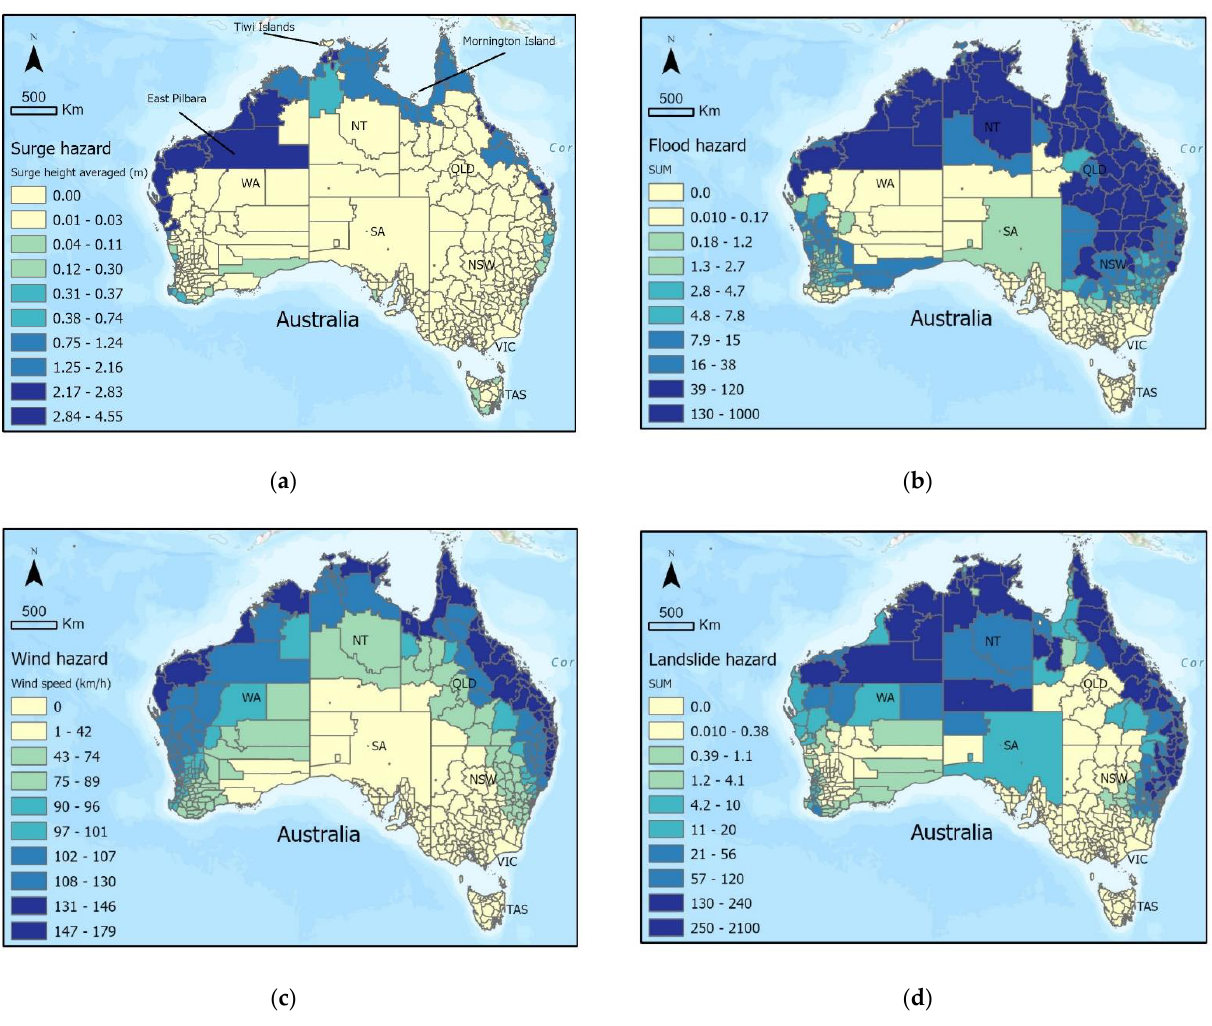
Figure 5. Hazard maps of storm surges ( a ), floods ( b ), wind ( c ), and landslides ( d ) associated with tropical